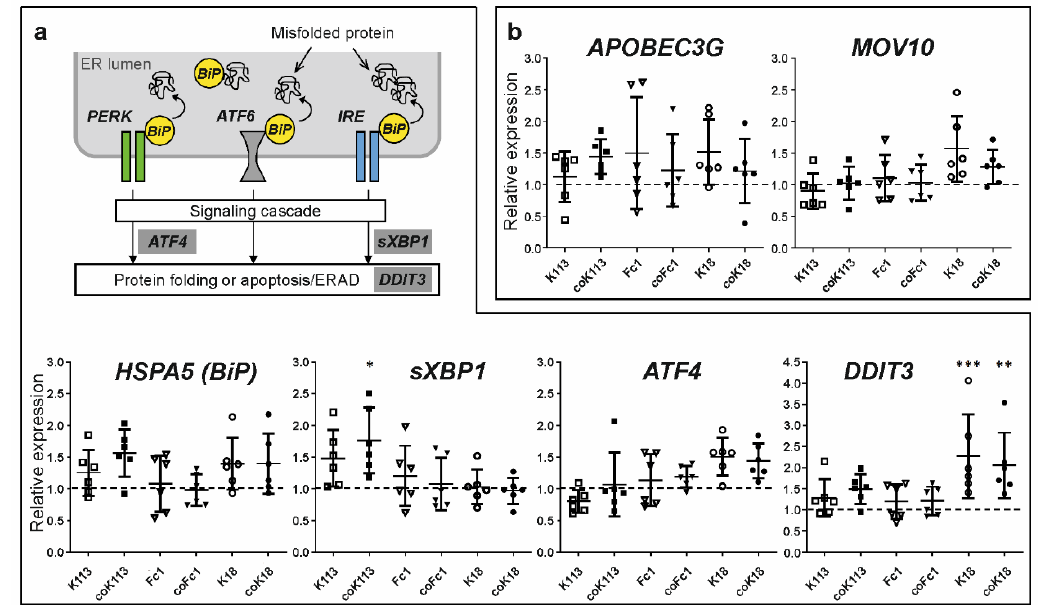
Figure 5. Influence of HERV ENV expression on antiviral response and unfolded protein response in transfected HEK293 cells. ( a ) The simplified scheme shows key players of the unfolded protein response (UPR). The ER chaperone immunoglobulin binding protein (BiP), which is encoded by the gene HSPA5 , is transiently bound to three protein sensors anchored in the ER membrane: PKR-like ER kinase (PERK), activating transcription factor 6 (ATF6), and inositol-requiring enzyme (IRE). If misfolded proteins accumulate in the ER lumen, BiP selectively binds to hydrophobic regions of these proteins and detaches from the membrane sensors at the same time. Hence, they become activated via oligomerization, autophosphorylation, or glycosylation. As a result, a signaling cascade is triggered, which leads to enhanced protein folding or ER-associated degradation (ERAD). The expression normalized to GAPDH and relative to empty vector-transfected cells (dashed grey line) was determined. The graphs show single data points and mean values ± standard deviation. Statistics: one-way ANOVA with Dunnett’s multiple comparison test; *** p < 0.001; **, p < 0.01; * p < 0.05, n = 6. ( b ) Relative expression of genes involved in viral defense mechanisms after transfection of WT and codon-optimized HERV envelope protein sequences in HEK293 cells. Expression was normalized to GAPDH and empty vector-transfected cells were set as one (dashed grey line).